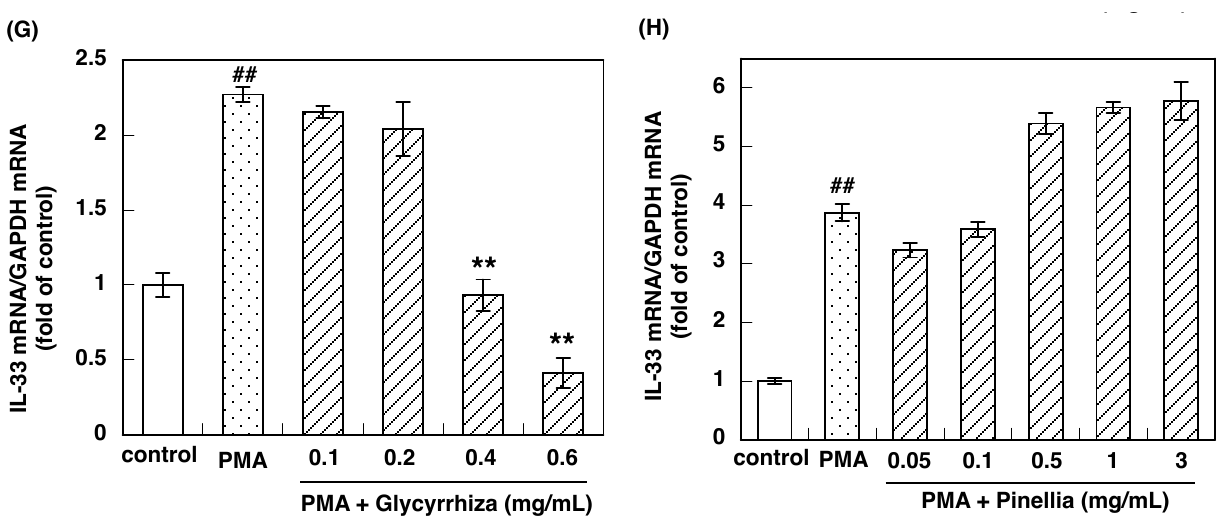
Figure 2. Effects of eight crude drugs of SST on PMA-induced up-regulation of IL-33 mRNA. Swiss 3T3 cells were treated with Ephedra herb ( A ), cinnamon bark ( B ), processed ginger ( C ), Asiasarum root ( D ), peony root ( E ), Schisandra fruit ( F ), Glycyrrhiza ( G ), and Pinellia tuber ( H ) for 12 h before stimulation with 100 nM PMA. After stimulation with PMA for 3 h, the cells were harvested, and total RNA was prepared. IL-33 mRNA levels were determined using quantitative RT-PCR. Data are expressed as means ± SEM ( n = 3–4). ## p < 0.01 vs. control; * p < 0.05, ** p < 0.01 vs. PMA.